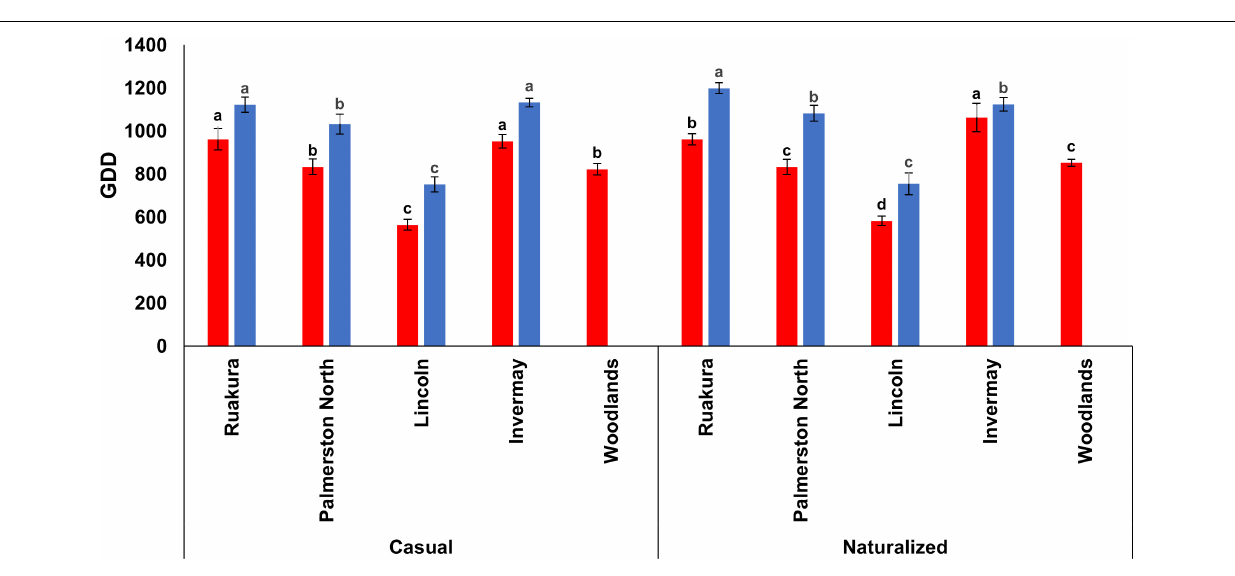
and Lincoln, respectively, in the first experiment ( Figure 4